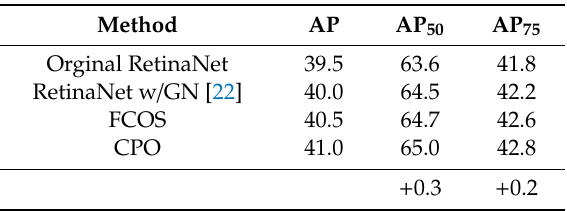
Figure 6. Class-agnostic precision-recall curves when intersection-over-union (IOU) = 0.50 and 0.75. Table 2. Class-agnostic detection performance.